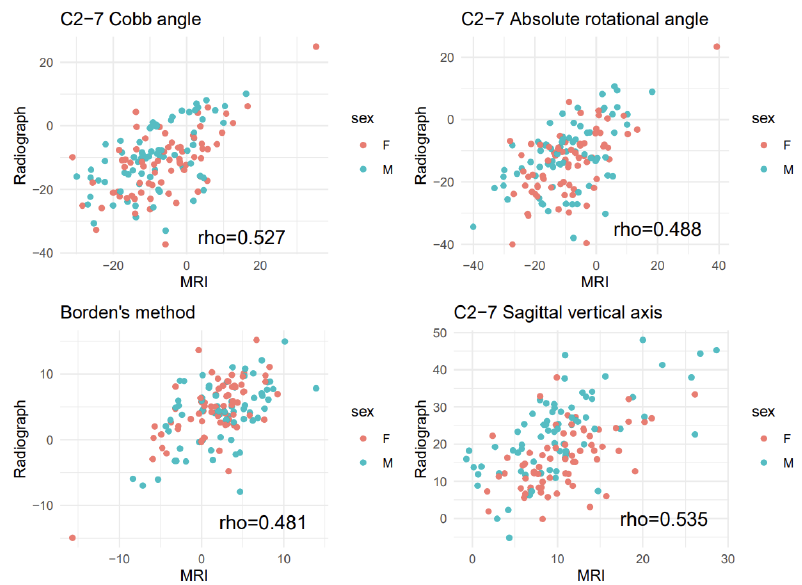
Figure 3. Scatter plot of radiographic and magnetic resonance imaging (MRI) measurements. Rho indicates Spearman correlation coefficient (without stratification by sex).